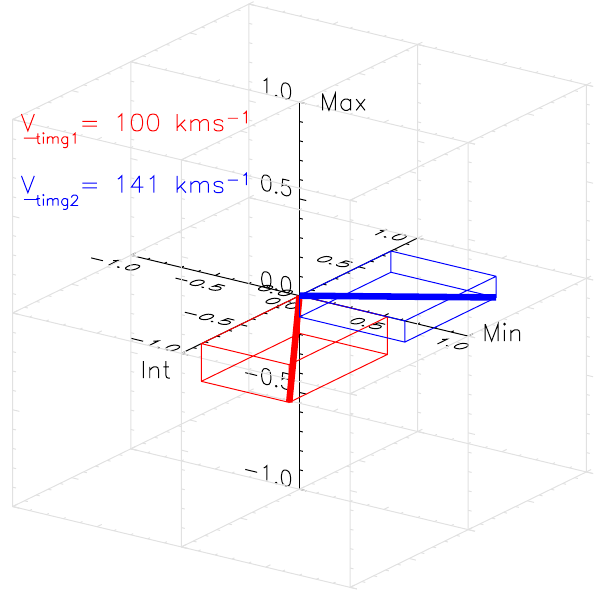
Fig. 13. V timg vectors produced from constant flux surfaces on 13 August event in the unit variance frame in the same format as Fig. 6. The directions “Min”, “Int” and “Max” correspond to the minimum, intermediate and maximum variance directions plotted in GSM unit space in Fig.